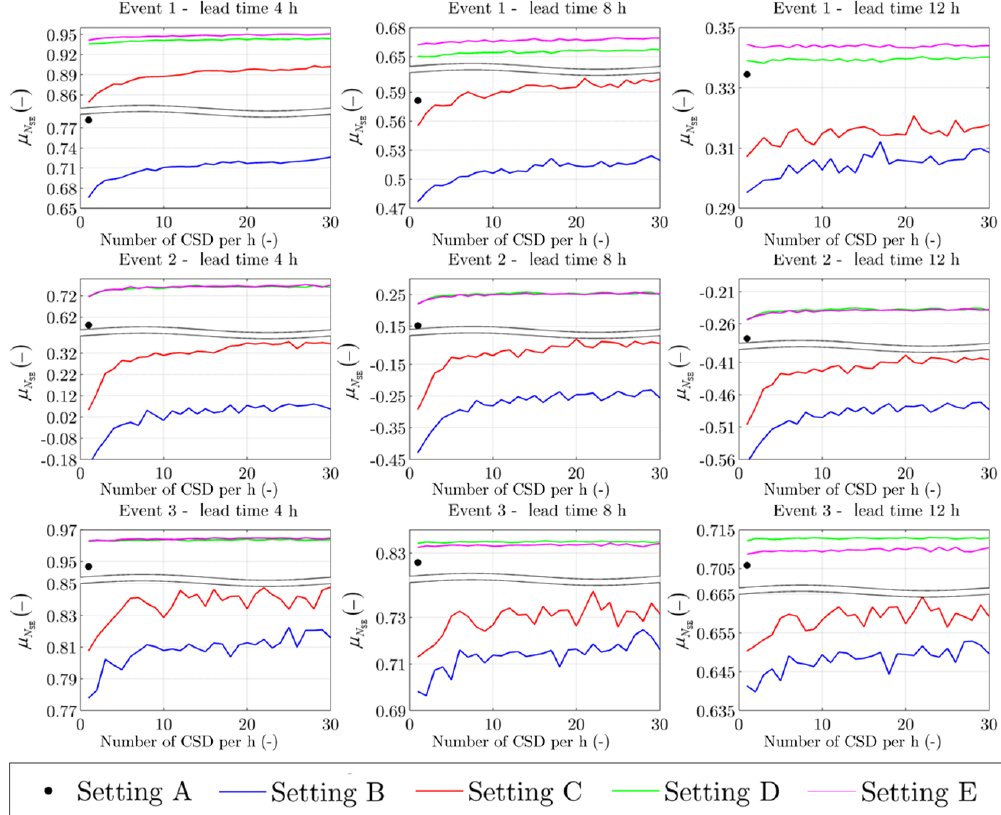
Figure 16. Model performance expressed as the mean of the Nash–Sutcliffe efficiency µ N crowdsourced data during the three considered flood events for the three lead time values (left panels: 4h; central panels: 8h; right panels: 12h) of scenario 11, for the five experimental settings (A to E) in the Bacchiglione catchment. vide similar µ N as the values obtained with scenario 9. SE